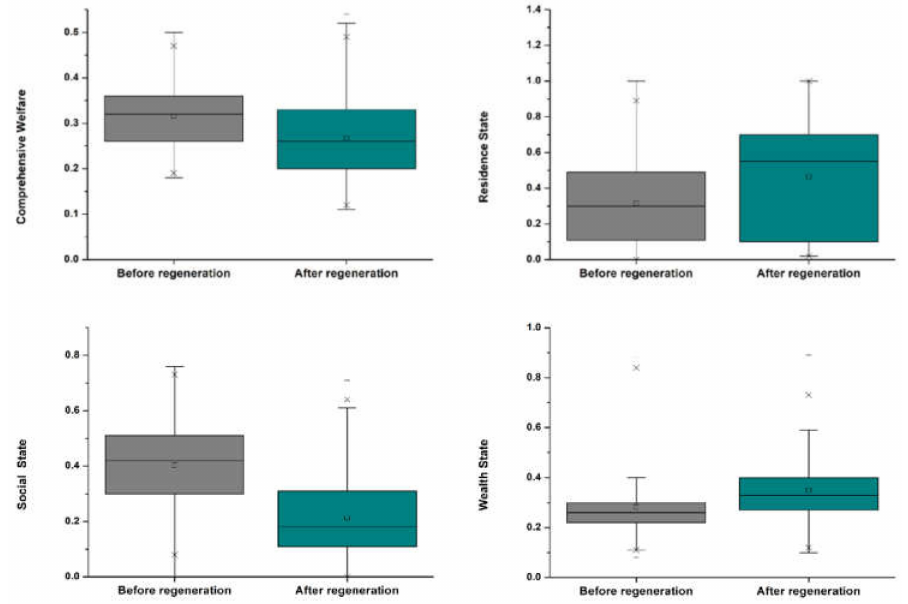
Figure 3. Box plot of sample welfare change